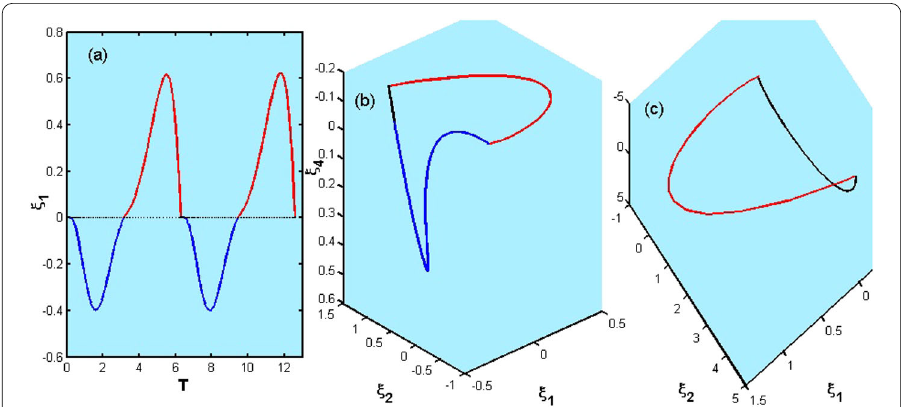
Figure 5 Period-one orbit with a segment of sliding motion established by ¯ ξ ∈ M 0 – . ( a ), ( b ) If ¯ ξ 4 = 0, β – = 2.